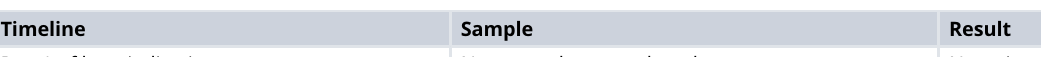
Table 1. Summary of the SARS-CoV-2 RT-PCR